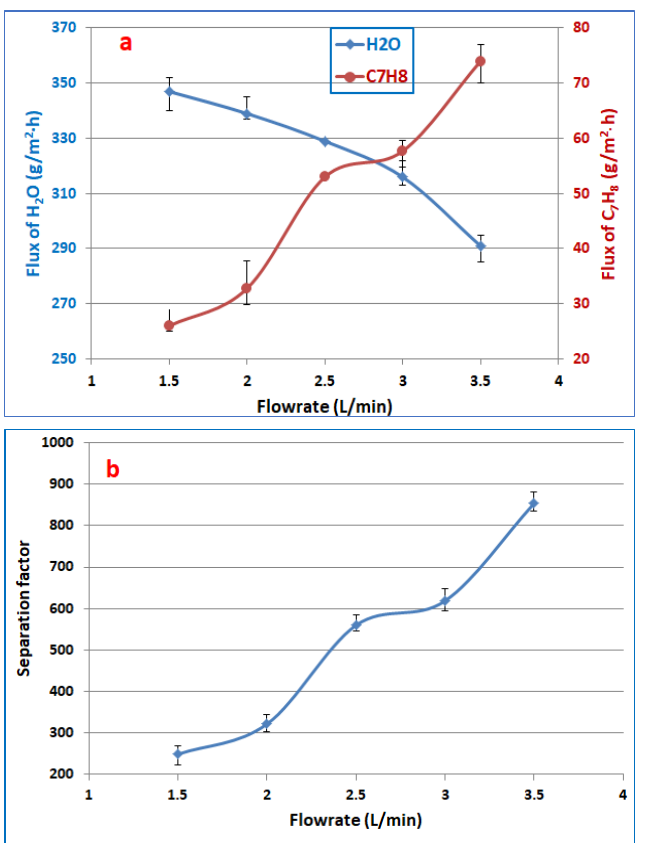
Figure 4. Effect the feed flowrate on ( a ) fluxes of toluene and water, ( b ) separation factor, at 300 ppm toluene feed concentration and 30 °C feed temperature.